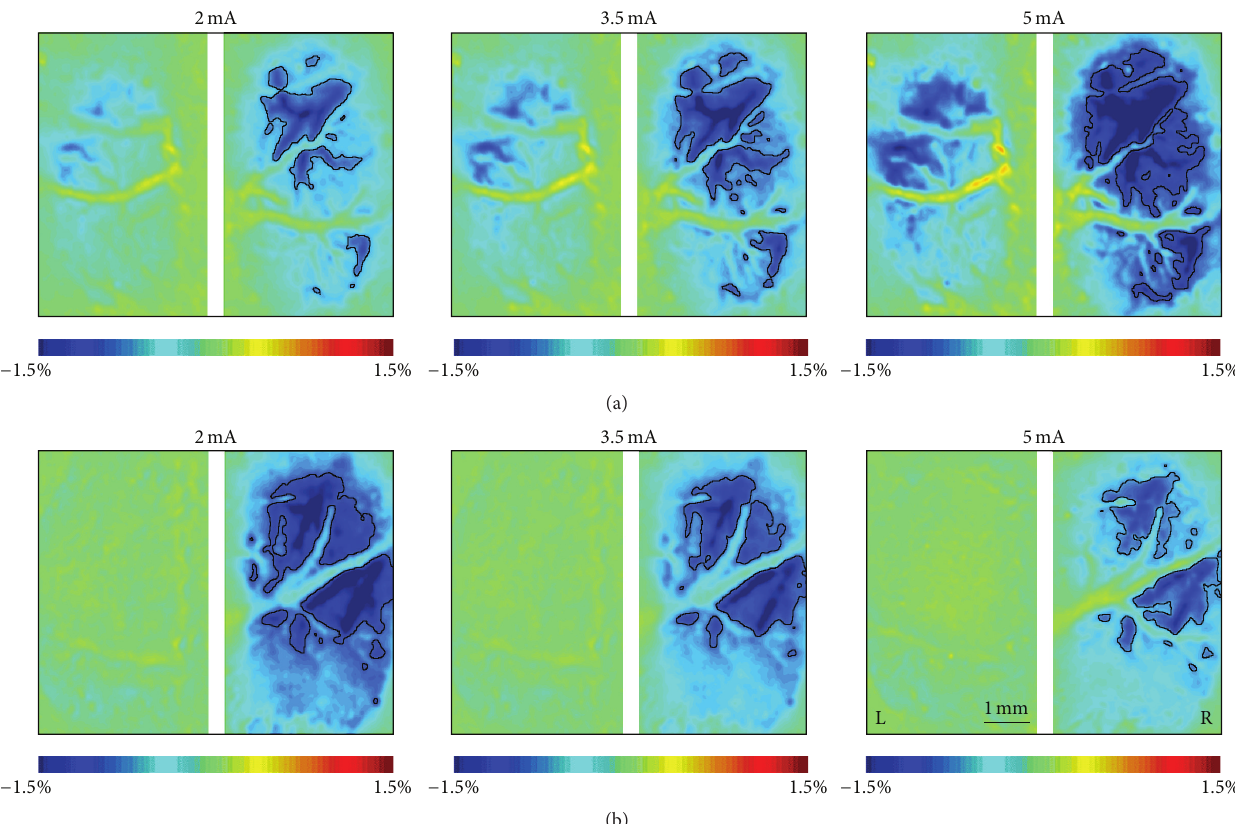
Figure 4: Optical intrinsic signal (OIS) images at 24 h after sham surgery or photothrombotic stroke in Control group (a) and Stroke group (b). During the imaging, the left hind paw was stimulated with different intensity of currents at 2mA, 3.5 mA, and 5 mA, respectively. The contour lines showed the response areas with more than 50% maximum